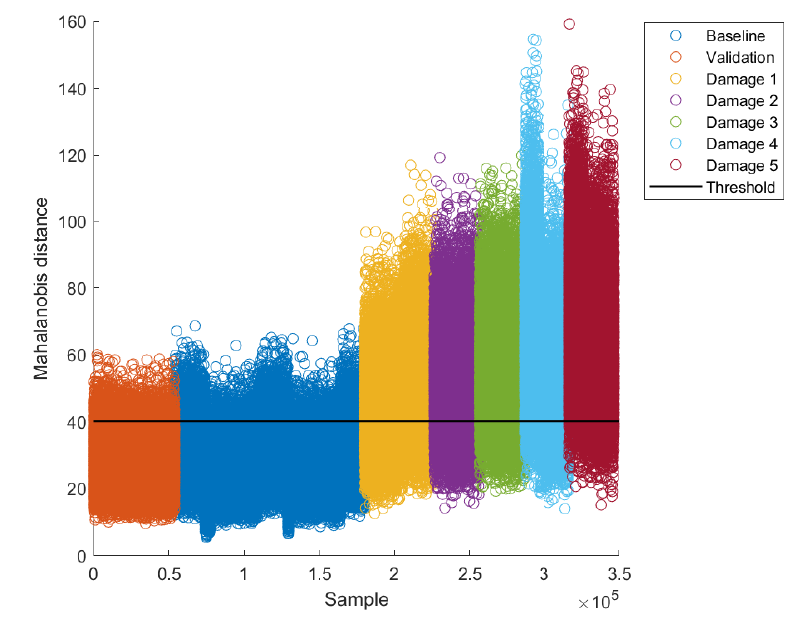
Figure 13. Results for an excitation frequency of 16.25 Hz with optimum